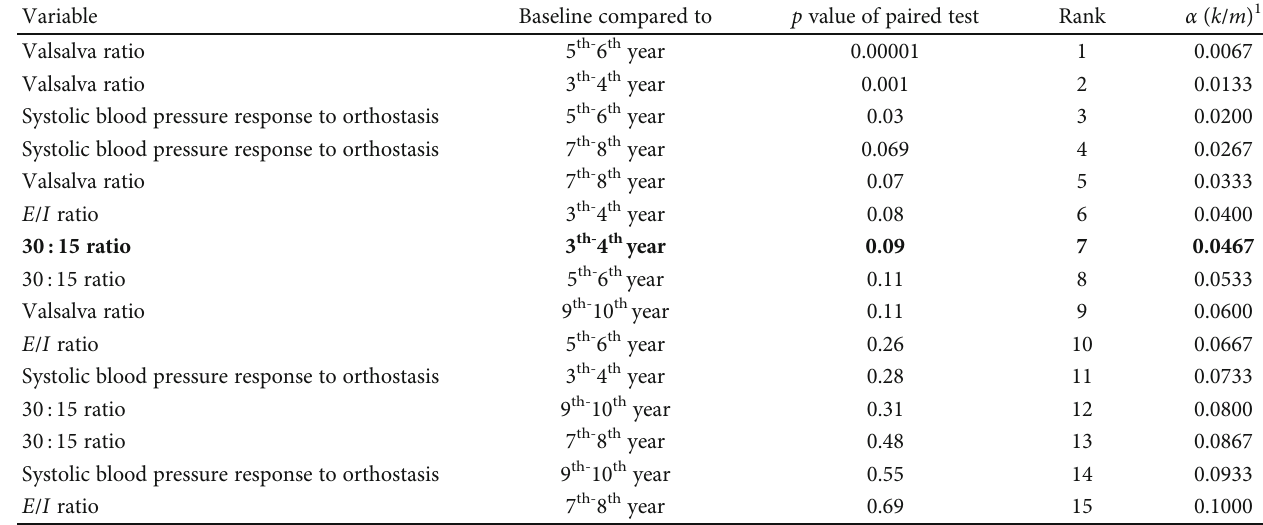
Table 3: Benjamini-Hochberg correction for multiple testing in autonomic